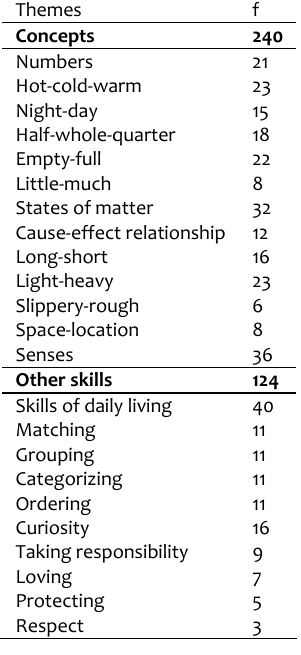
Table 4. Concepts that are tried to be acquired through the science and mathematics